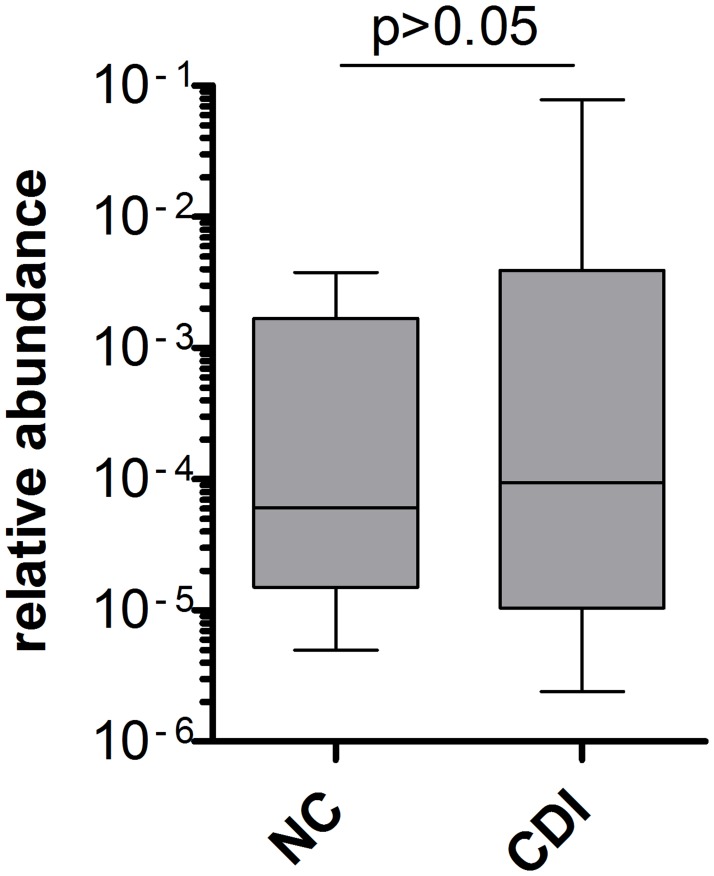
BaiCD gene cluster abundance in relation to the total bacterial load.The ratio baiCD/16S rDNA was determined for a subset of baiCD-positive fecal samples. No significant difference in the relative baiCD gene cluster abundance between NC (C. difficile negative) and CDI (C. difficile infection) samples could be detected (n = 9 in each group; box-and-whiskers plot, median-IQR-min/max, one-way ANOVA, p = n.s.).